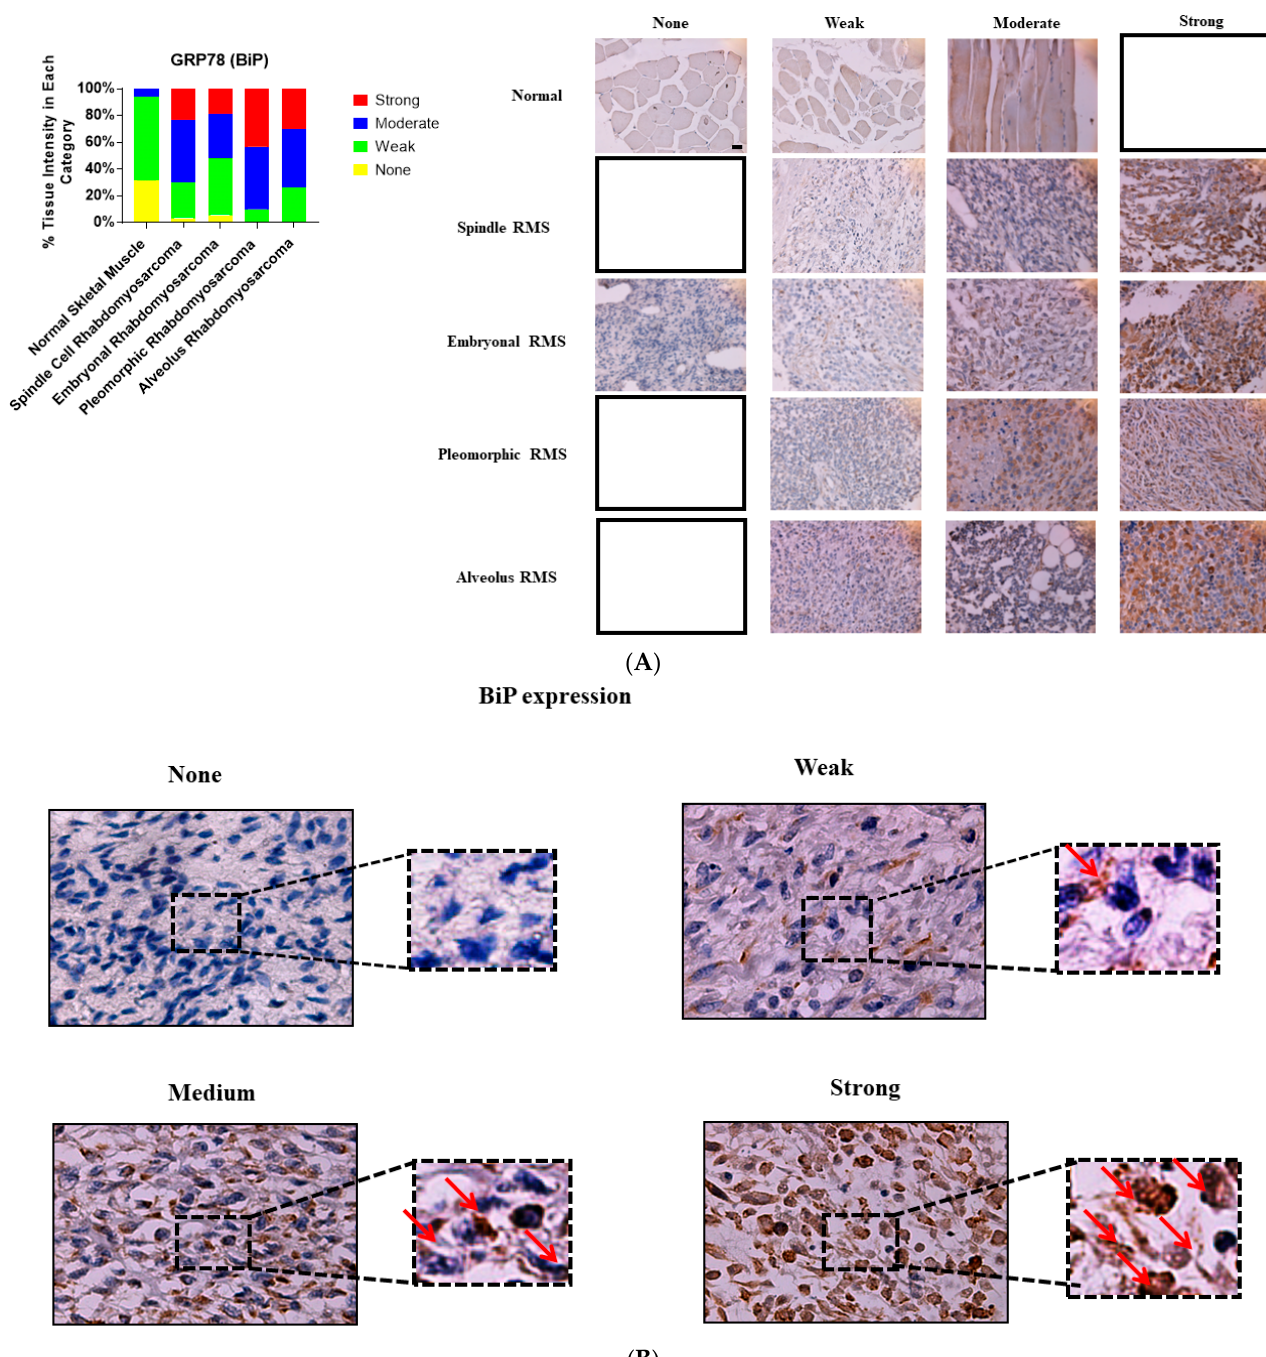
Figure 1. Immunohistochemical staining for BiP in human skeletal muscle and RMS tissue. ( A , B ). We detected BiP expression (red arrow) in a human RMS TMA; details on the TMA were outlined in the Section 2. Three independent pathologists blindly evaluated the immunohistochemical BiP expression (None = no staining; W: Weak staining; M: Moderate staining; S: Strong staining); the empty slots indicate that there were no samples in that specific group (None, W, M, or S). Our results show that BiP is associated with RMS (Table 1). The results also show that BiP expression is associated with ARMS, ERMS, PRMS, and SRMS (Table 2). The scale bar refers to 50 µ